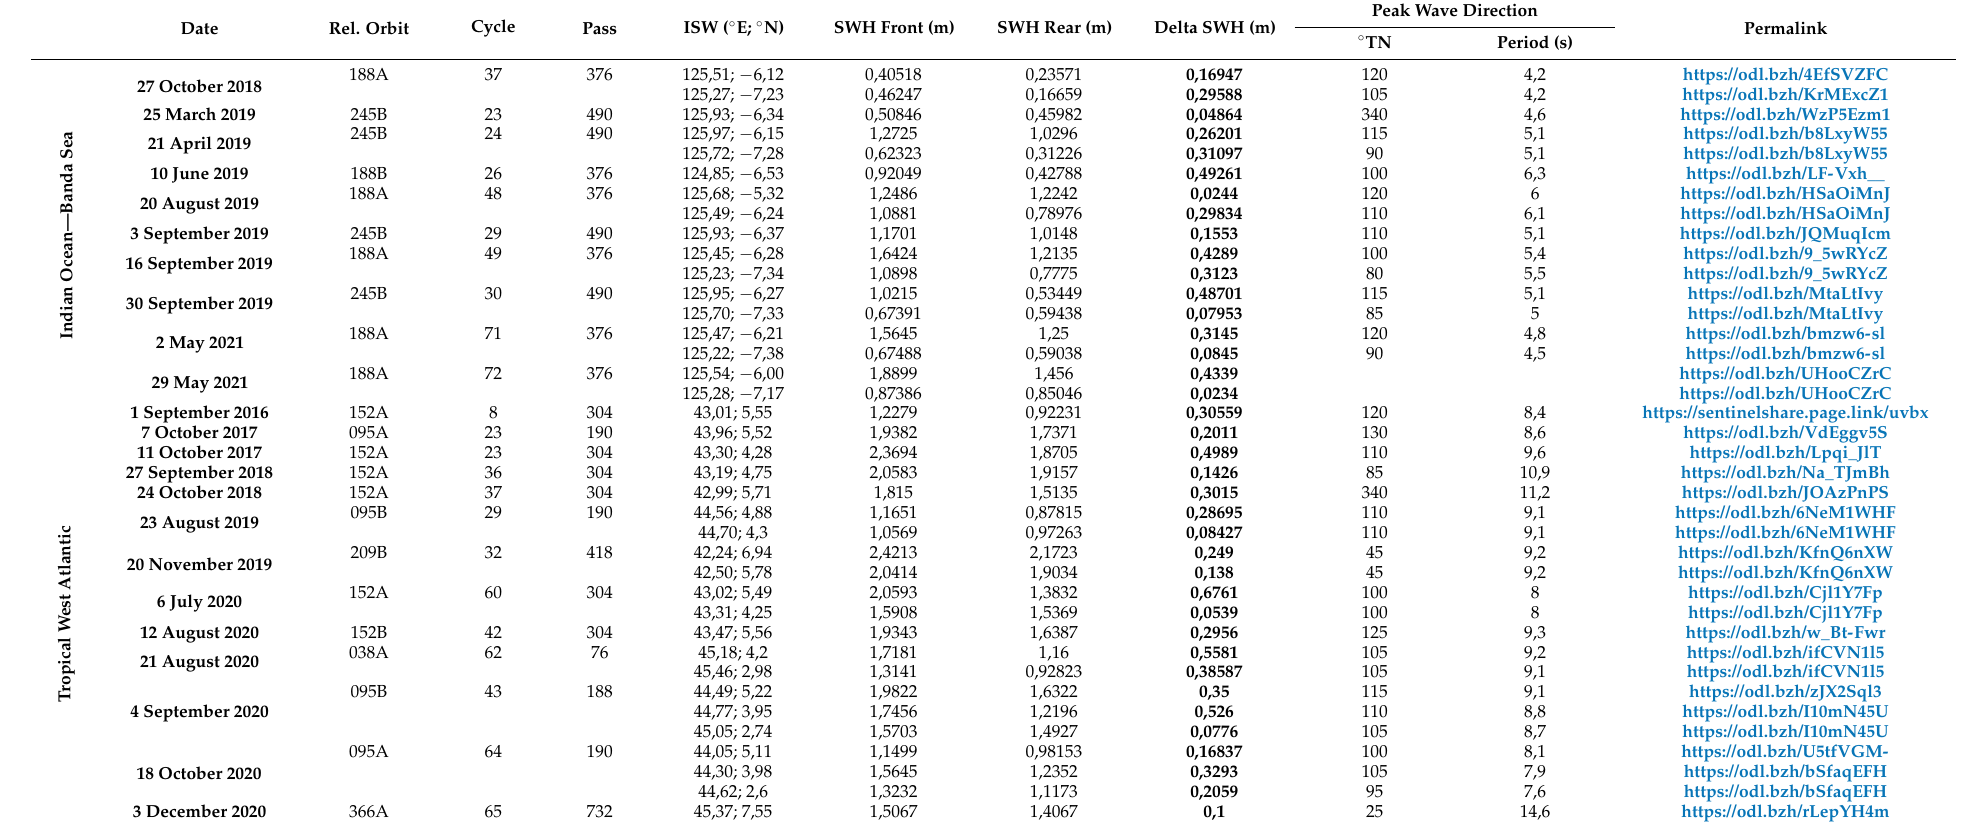
Table 1. List of Sentinel-3 cases exhibiting large-scale ISWs in optical imagery (OLCI) in synergy with the corresponding sea surface signatures in the SRAL altimeter. For each case, a respective measure of significant wave height (SWH) is given for leading (front) and trailing (rear) sections of the ISWs (as in Figure 4). Differences between these characteristic values ( ∆ SWH = SWH front − SWH rear ) are also shown. For each acquisition, representative estimates are also shown for the surface wave field (including direction and wave period—from https://earth.nullschool.net/, accessed on 10 May 2021). All cases can be accessed in their corresponding permalinks from OceanDataLab (https://www.oceandatalab.com/home, accessed on 10 May